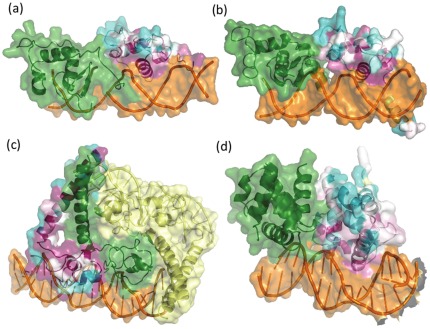
Homodimers exhibiting ligand-dependent global asymmetry.This figure shows examples of ligand-dependent asymmetric homodimers. a). Orphan nuclear receptor NR1D1 (GloA_Sc – 15.49; PDB – 1a6y) b). Vitamin D3 receptor (GloA_Sc – 17.47; PDB – 1kb2) c). Heme activator protein (GloA_Sc – 9.08; PDB – 1hwt) d). Stage 0 sporulation protein A (GloA_Sc – 11.79; PDB – 1lq1). One of the chains of the dimer is shown as a green colored cartoon whereas the other chain provides a color-based representation of the conservation of every residue position, calculated using ConSurf (refer Methods). In the chain colored based on ConSurf scores, highly conserved residues are colored magenta whereas poorly conserved residues are colored cyan and moderately conserved residues are shown in white. Any other ligand(s) bound to the dimer is depicted as orange spheres. Other chains closely interacting in the asymmetric unit are colored yellow.